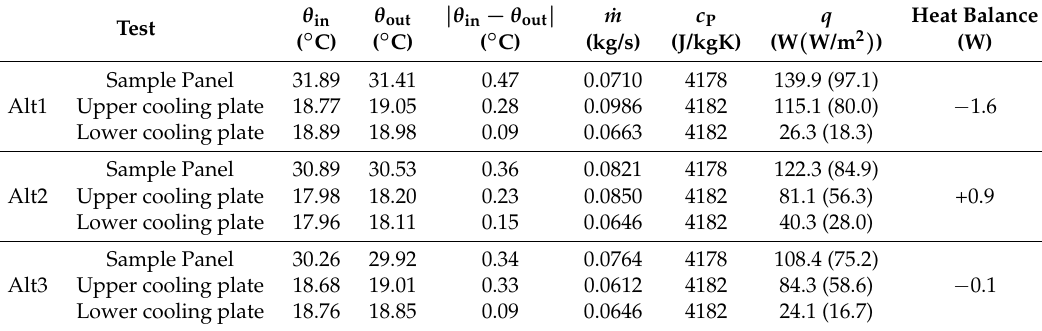
Table 3. Experimental results of the supply–return water temperature and flow rate, and of the heat